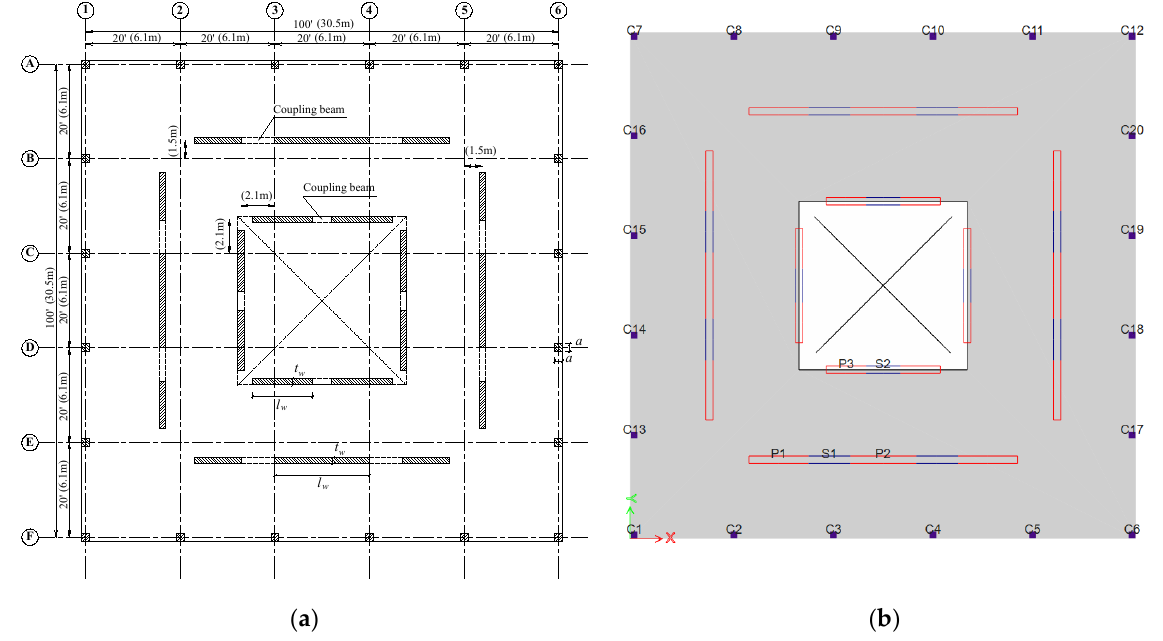
Figure 1. ( a ) Typical floor layout configuration; ( b ) floor plan on ETABS.